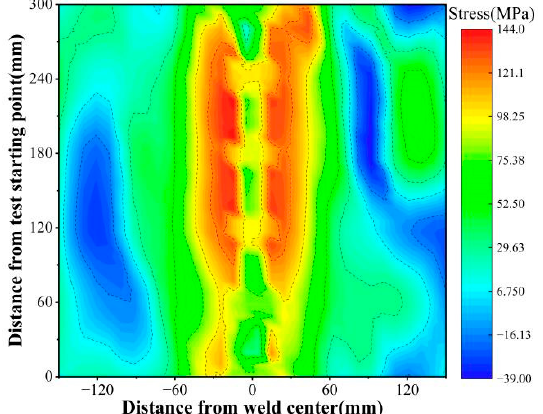
Figure 9. Longitudinal residual stress distribution cloud of measured material.